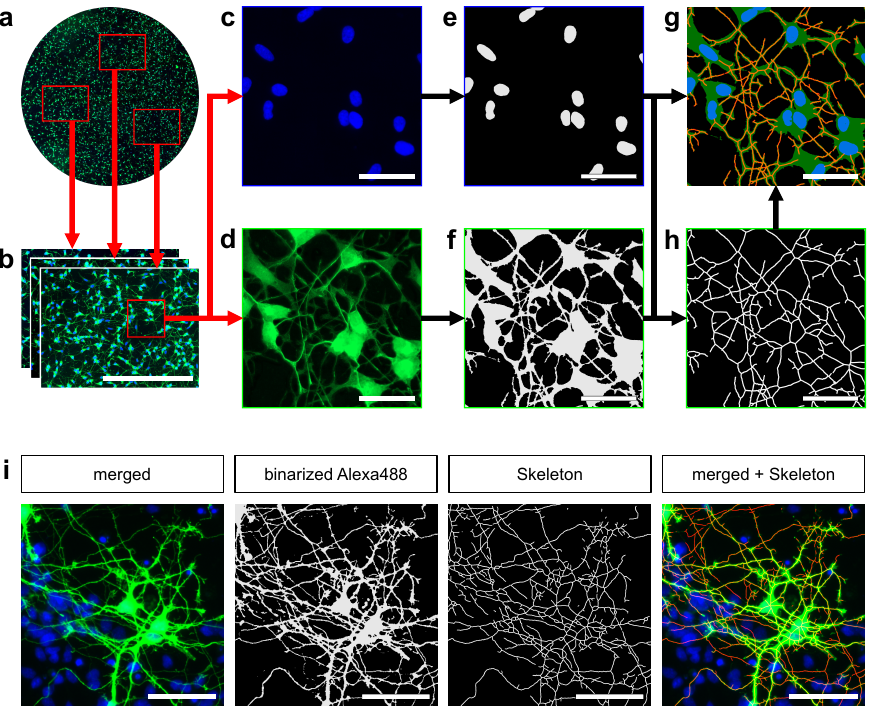
Figure 1. Fully automated skeletonization of neurite outgrowth. ( a ) Shows a representative image of a coverslip ( not to scale ) from which three images ( b ) (scale bar = 500 µm) are added to the image data set. Each analyzed image spans 1376 × 1038 px (representing 884.89 µm × 667.52 µm). For better visualization a representative section is shown in the following ( c , d ). Scale bars = 50 µm. For analysis of neurite outgrowth and morpholgy Alexa 488 channel ( c ) and DAPI channel ( d ) are seperated. ( e ) shows the processed DAPI channel image as a binary image. In ( f ) the processed Alexa 488 channel is depicted, showing the neurite and soma area as a binary image. The Alexa 488 channel image is skeletonized. The full skeleton without soma substraction is shown in ( h ). For better visualization the skeleton was morphologically dilated. For visual evaluation the skeleton with soma substraction, the binarized Alexa 488 and DAPI channel image combined into one image ( g ). Representative images of MDN as they were used in the validation of the presented approach are shown in ( i ). First, the input image is depicted with a merged Alexa 488 and DAPI channel image. For both Alexa 488 images the binarized image and afterwards produced skeleton are shown. For better visualization the skeleton was morphologically dilated. By combining the final skeleton and the input image the effectiveness of the skeletonization can be